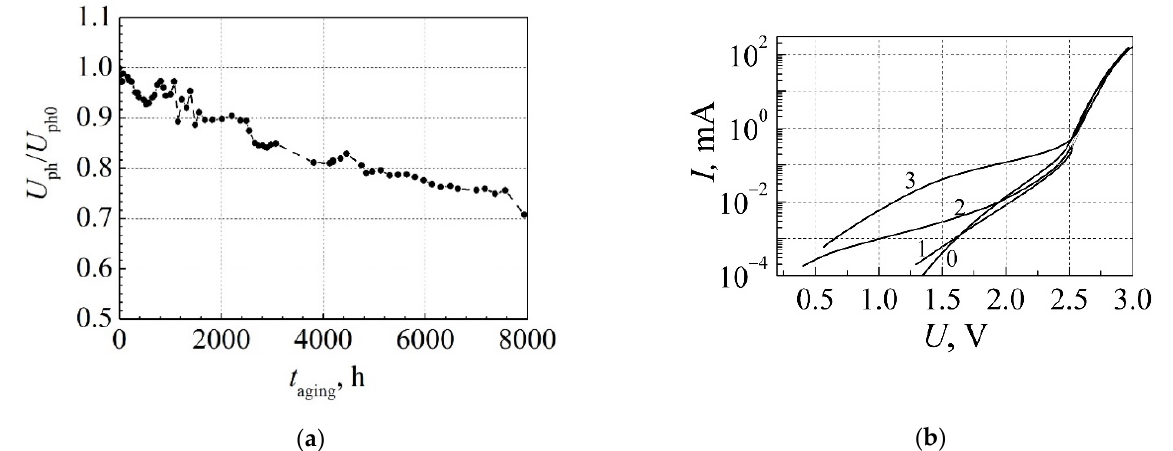
Figure 10. ( a ) Dependence of photovoltage (proportional to the LED output light power) on aging time measured at 30 mA current; ( b ) current–voltage characteristics after different aging time in h: 0–before aging; 1–2200; 2–2730;